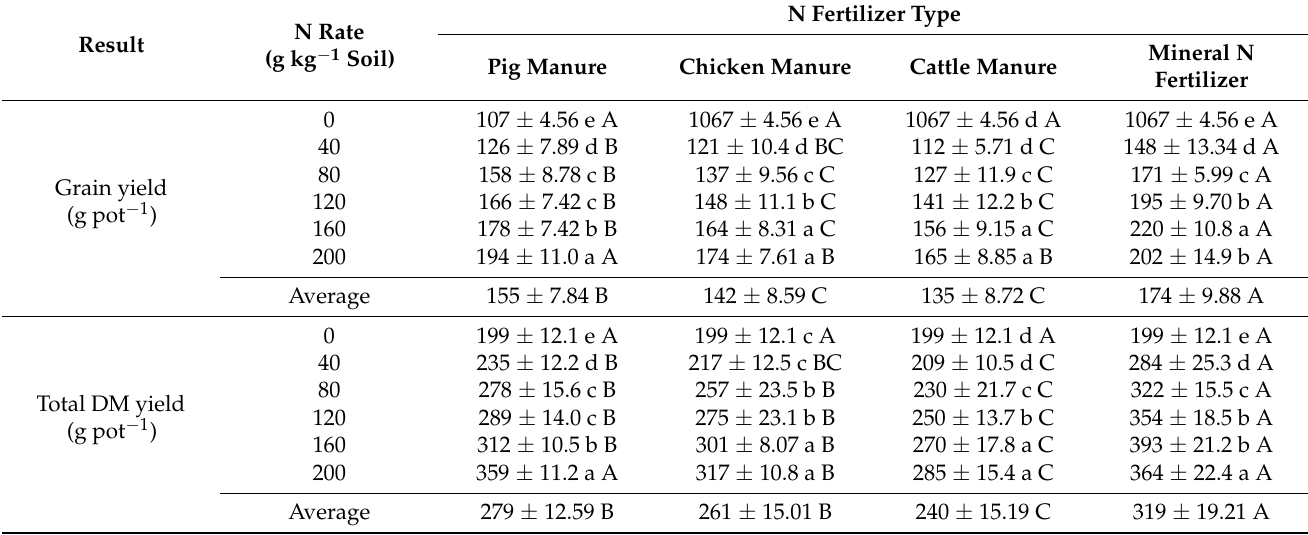
Table 2. Effects of different N fertilizers on summer maize grain yield and total dry matter.